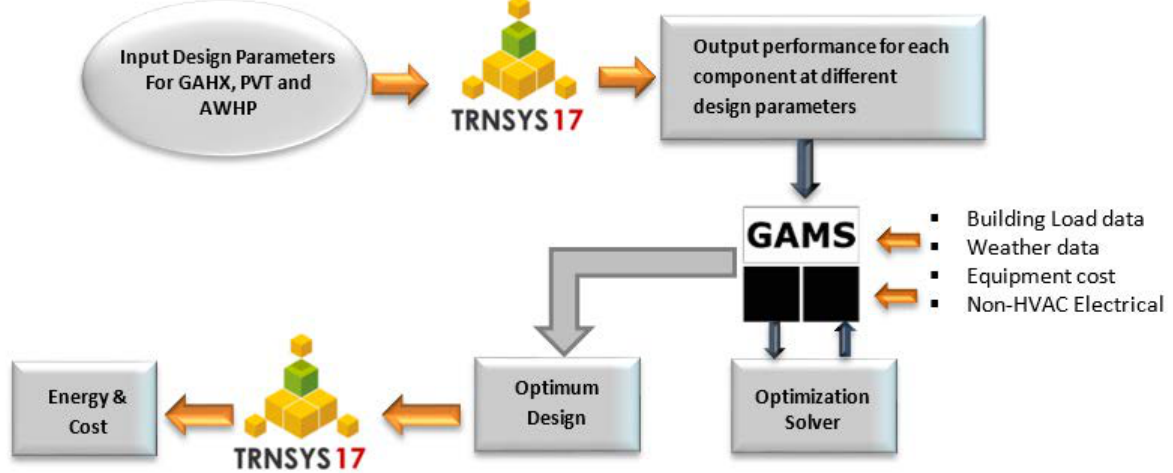
Figure 2. Flowchart design system optimization and simulation for Trigeneration System. Figure 3 presents GAHX outlet temperatures at different pipe lengths and outside air temperatures during summer/winter conditions. The GAHX performance data are based on a constant airflow rate of 2900 kg/h. The results showed that the outlet airflow temperatures from the GAHX range from − 1 ◦ C to 4 ◦ C when the outside air temperature is below zero degrees, with a GAHX length of 125 m. The outlet temperature from GAHX reaches 17 ◦ C on the warmest day of 35 ◦ C. Moreover, for further increases in GAHX length, the outlet airflow temperature from GAHX increases in the winter season and decreases in the summer season. At a GAHX length of 500 m, there is no significant variation in outlet airflow temperature from GAHX in winter and summer seasons, with an average temperature of 7 ◦ C.